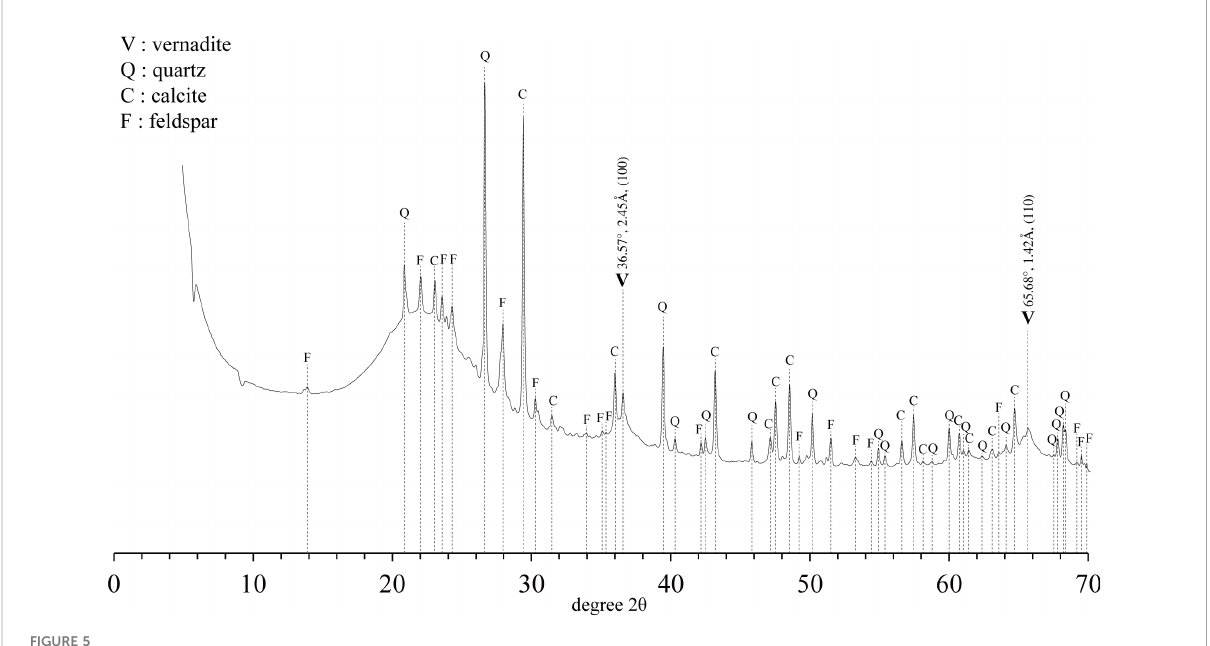
FIGURE 5 High resolution X-ray diffraction pro fi le of